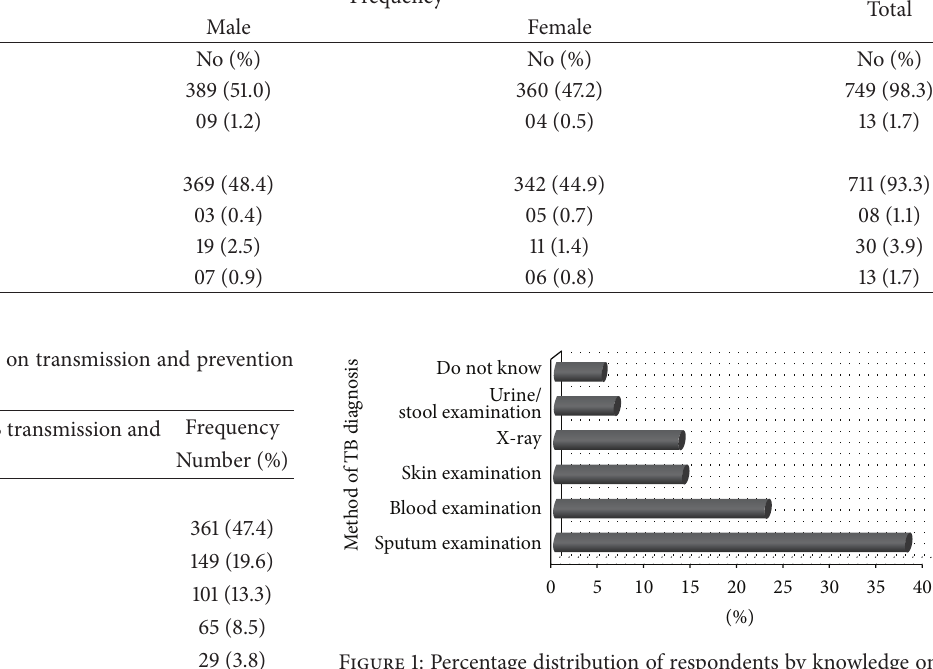
Figure 1: Percentage distribution of respondents by knowledge on method of TB